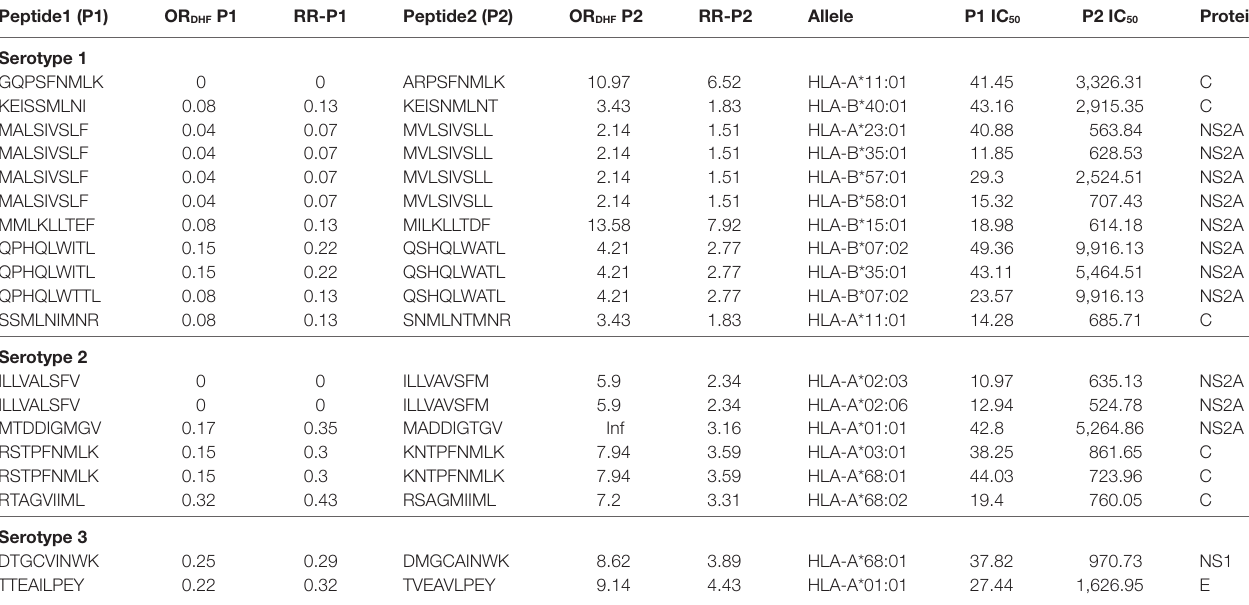
TaBle 3 | HLA-I binding double amino acid variants present differentially in dengue fever and dengue hemorrhagic fever (DHF) primary infection among different serotypes. Peptide1 (P1) Or DhF P1 rr-P1 Peptide2 (P2) rr-P2 allele Protein